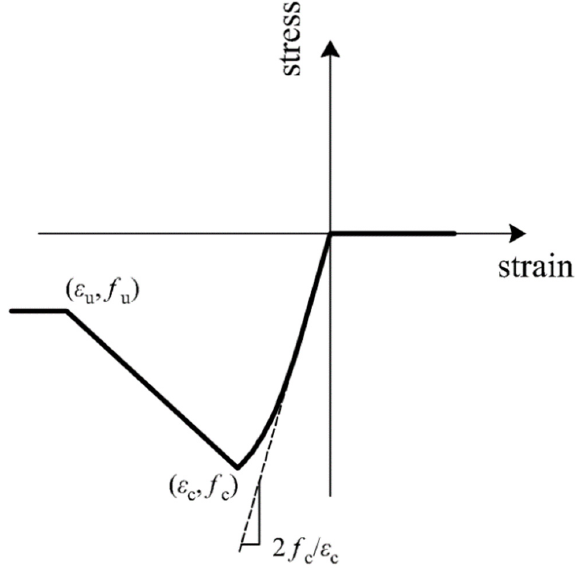
Figure 9. Material properties of concrete.